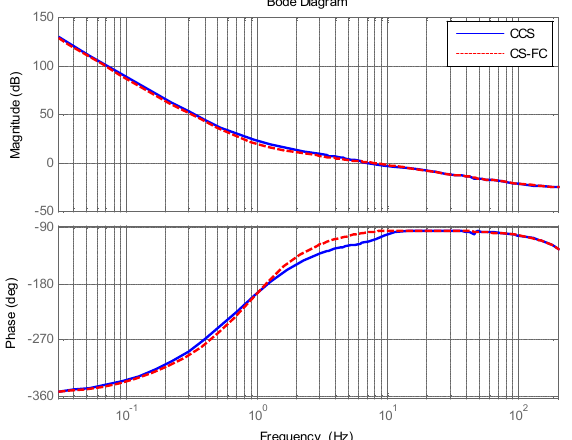
Figure 4. Target tracking open loop response of CCS and CS-FC.